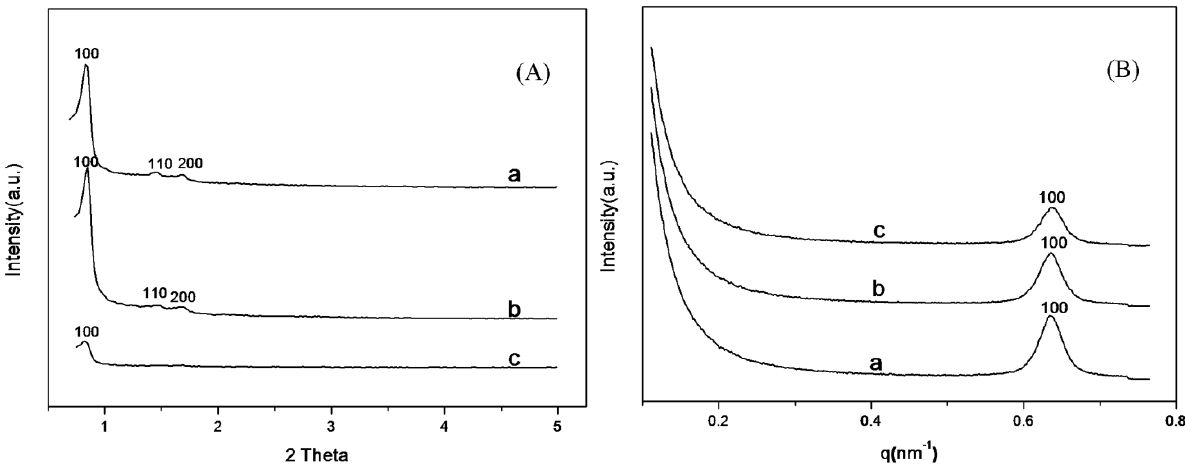
Figure 7. SEM images of SBA-15-ex and amine-grafted SBA-15-ex. ( A )